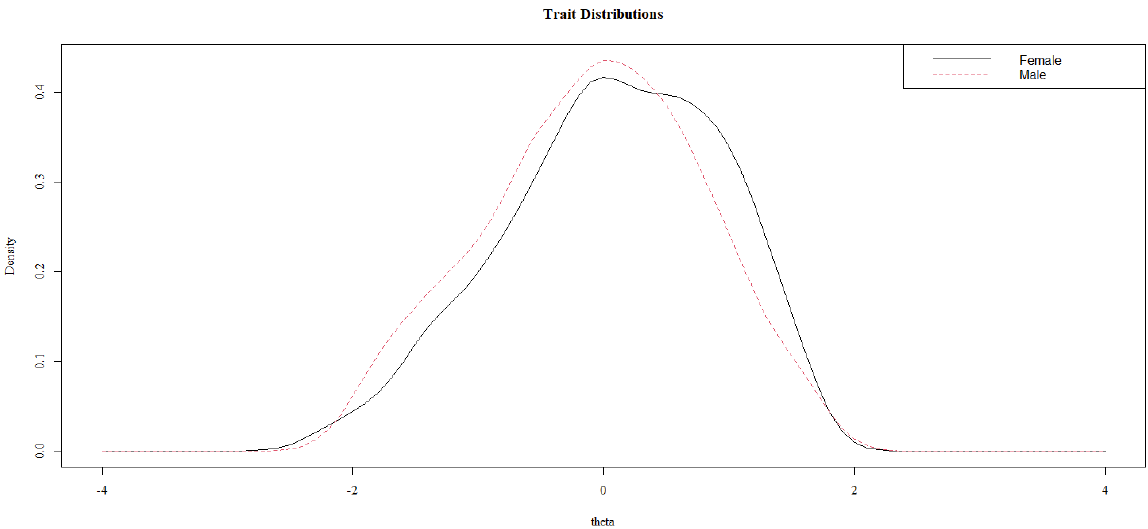
Figure 2. Theta distributions by gender.